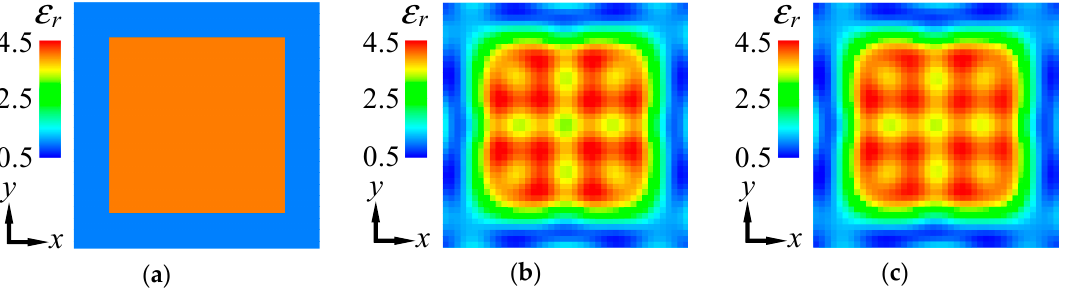
Figure 11. Reconstruction results for the cylindrical object after 50 iterations: ( a ) true image, ( b ) reconstructed image using information on the exact incident field, and ( c ) reconstructed image using information on the extracted incident field.